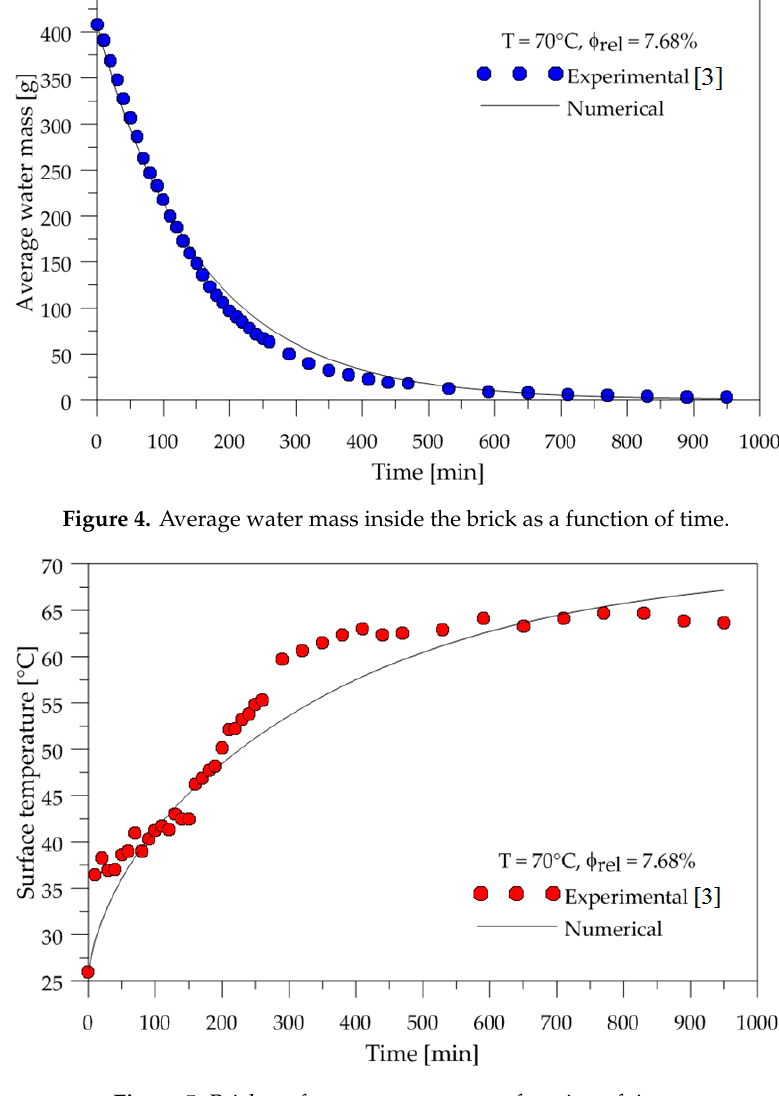
Figure 5. Brick surface temperature as a function of time.